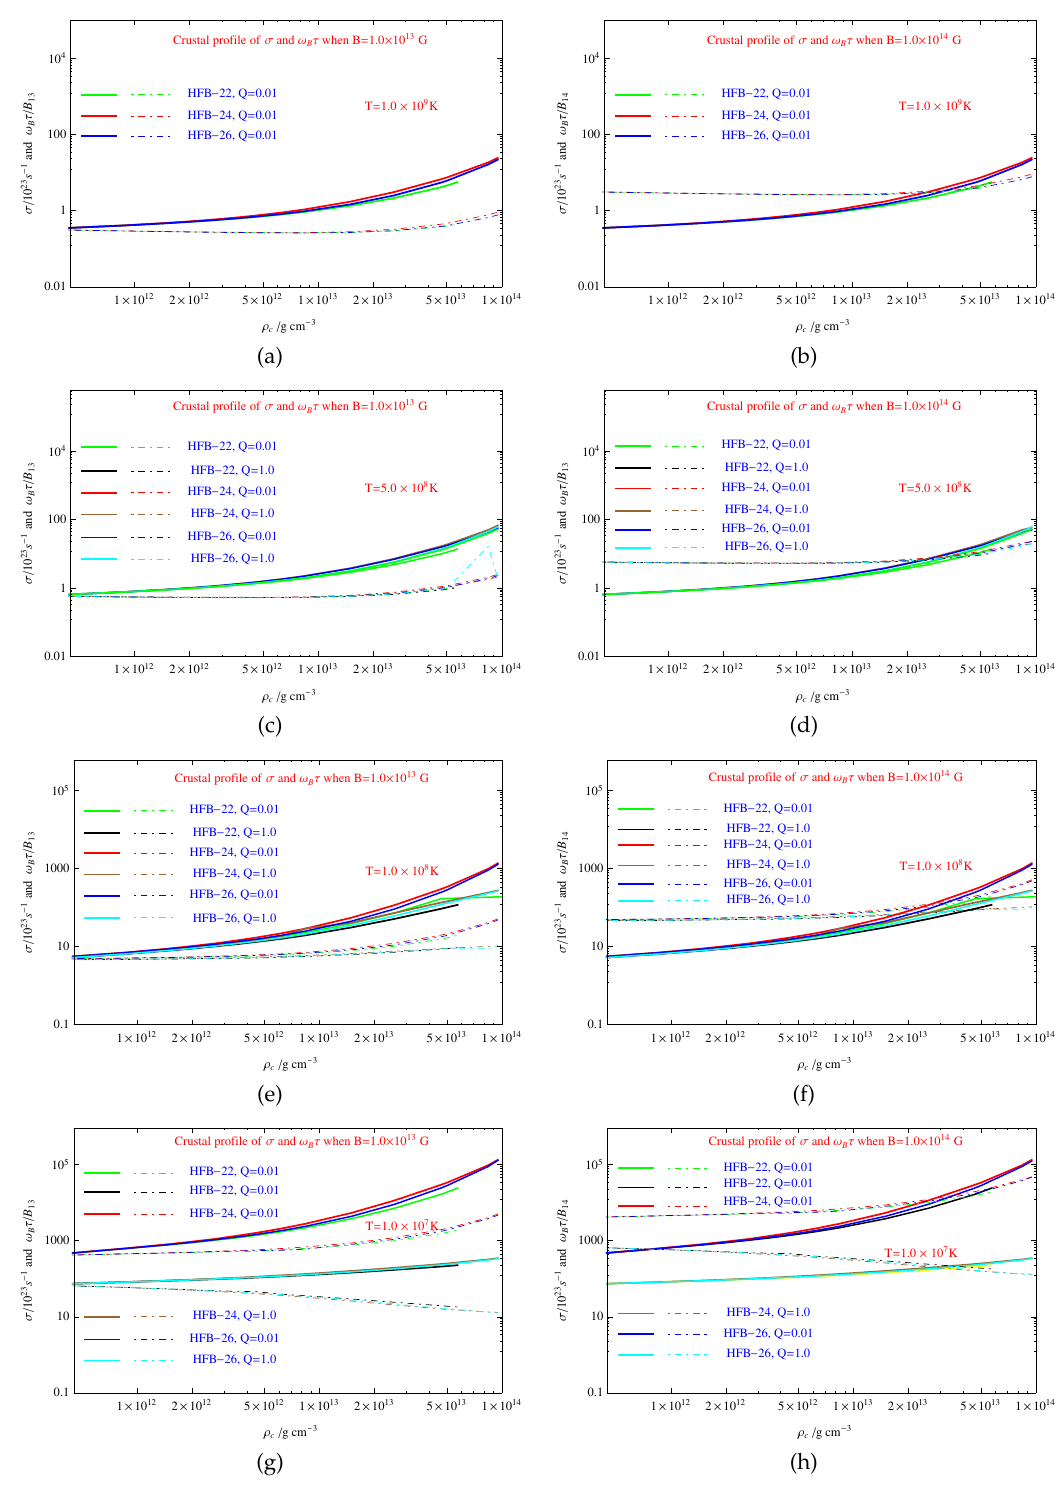
Figure 1. The relations of σ , ω B τ and ρ in the inner crust of a neutron star. The solid line and dot-dashed line are for σ and ω B τ , respectively. In ( a , c , e , g ), the fiducial magnetic field is B = 1.0 × 10 13 G; In ( b , d , f , h ), the fiducial magnetic field is B = 1.0 × 10 14 G. The crust is assumed to be